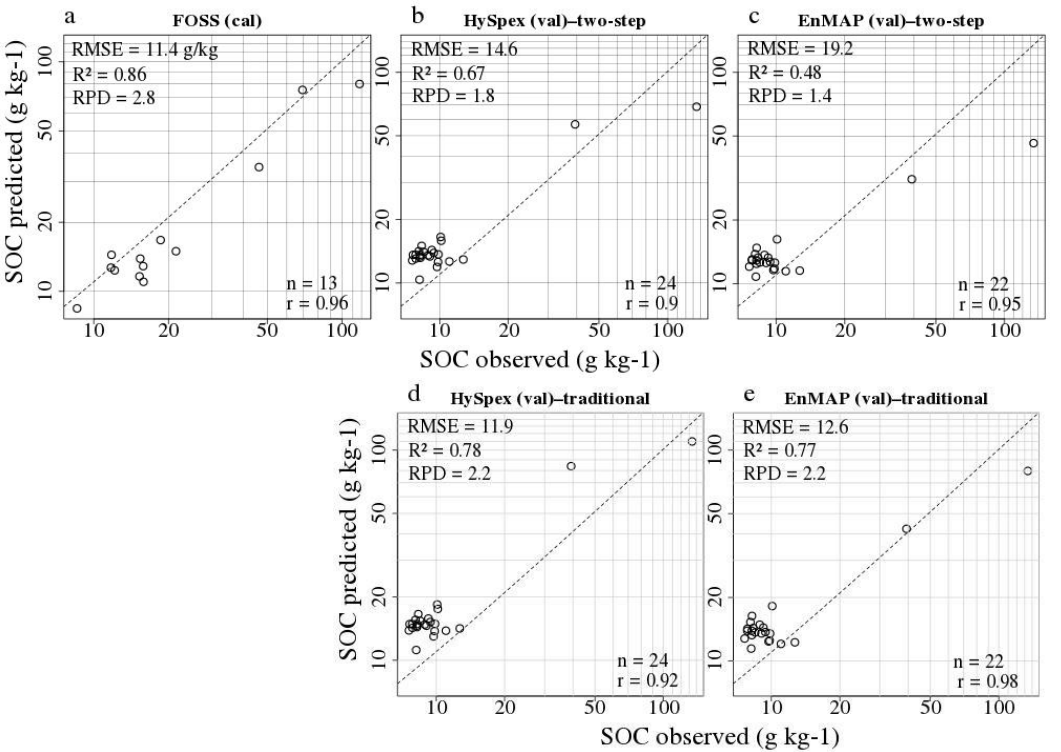
Figure 6. Measured versus predicted SOC contents on a logharitmic scale for the laboratory model (airborne calibration subset), airborne HySpex and simulated EnMAP imagery (airborne validation subsets). Left ( a ): Predicted SOC contents of the laboratory model result from the application of the local PLSR; middle ( b , d ): HySpex; and right ( c , e ): EnMAP. Top panel ( a – c ): SOC predictions result